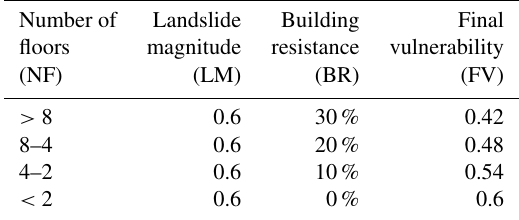
Table 5. Vulnerability related to the number of